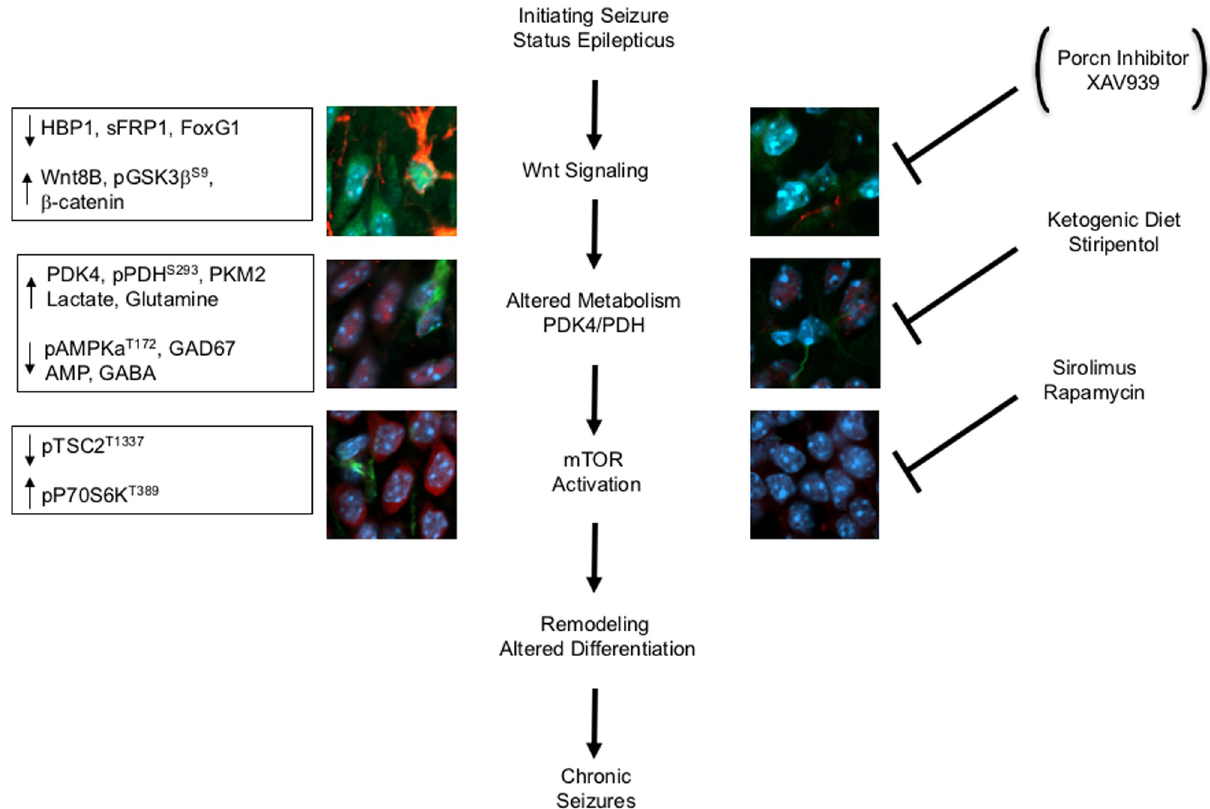
Fig 8. A summary scheme for potential drugs to target the Wnt-AMPK-mTOR pathway during epileptogenesis. Our epileptogenic mechanism model shows three target points for potential anti-epileptogenic drugs. First, a Wnt inhibitor may target the upstream of this pathway, but current treatments do not cross the BBB. Secondly, altered metabolism can be targeted by ketogenic diets and Stiripentol. Thirdly, mTOR activation can be targeted with mTOR inhibitors (e.g., Sirolimus and rapamycin). Collectively, the ideal therapy is a combination and nontoxic therapy aimed at multiple targets to alter remodeling and neuronal differentiation during the epileptogenic period to forestall the progression of chronic seizures.